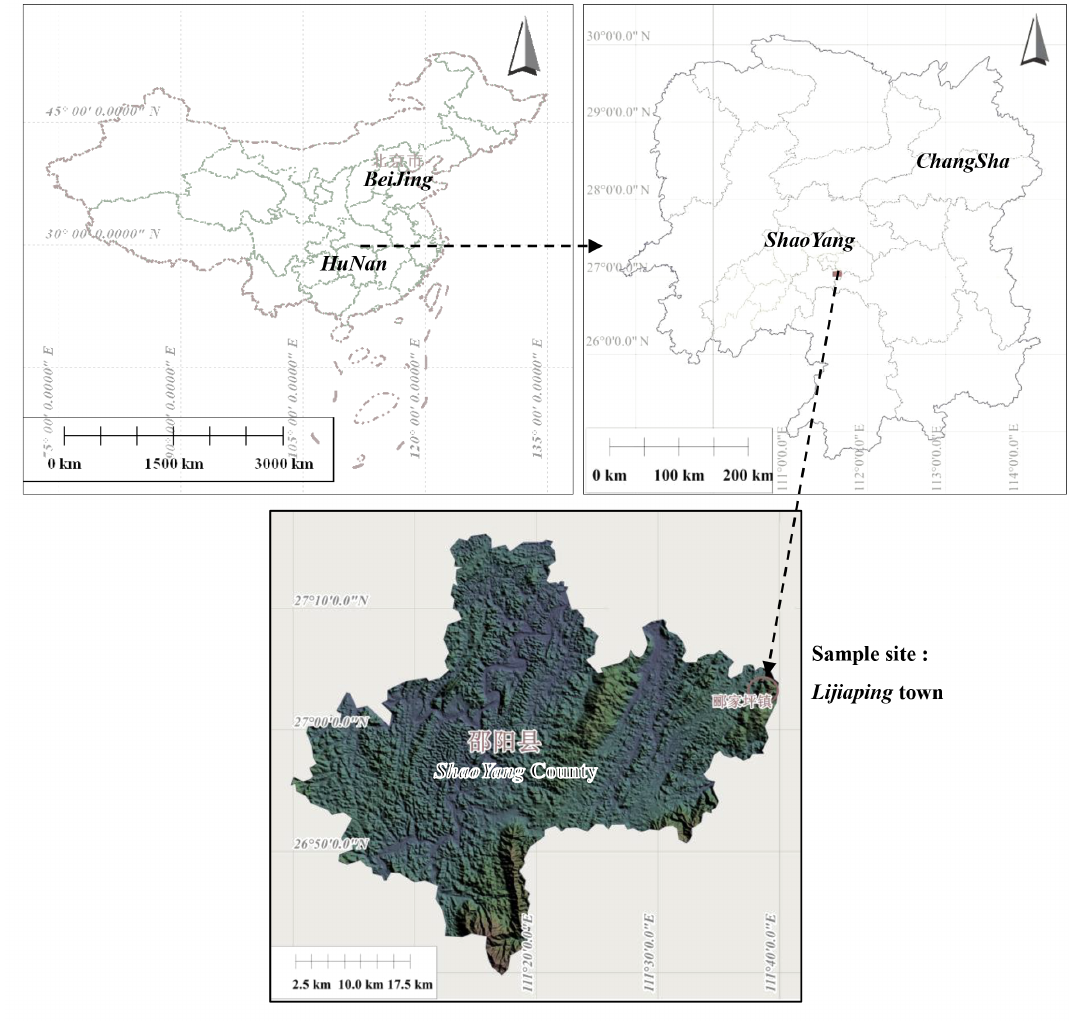
Figure 1. Geographical locations of the study sites.